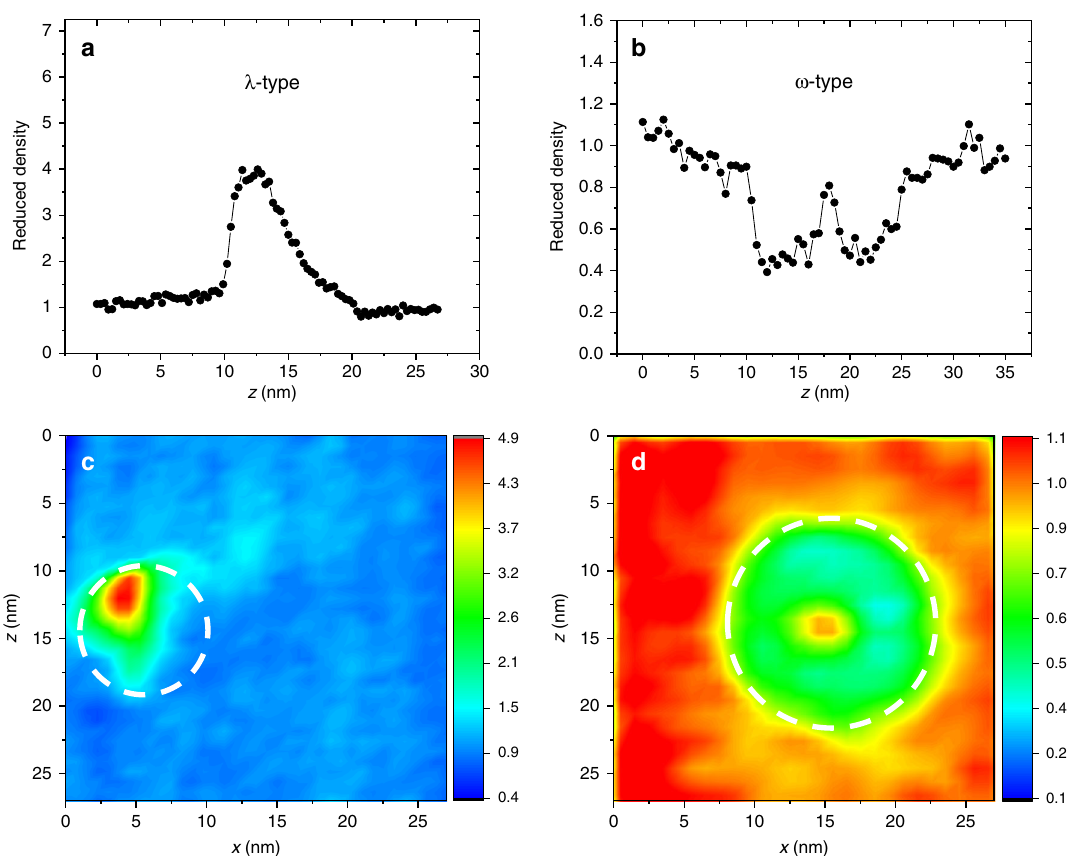
Fig. 2 1D local density pro fi les and 2D density contour plots at a void location. a and c are results from NiCoCr; b and d are results from doped NiCoCrFe. To produce 1D pro fi les, 5 nm diameter cylindrical ROIs are oriented perpendicular to the hemispherical surface of the APT reconstruction and pass through the void. 27 × 27 × 3 nm cuboidal ROIs through the center of the voids are used to calculate the 2D density contour